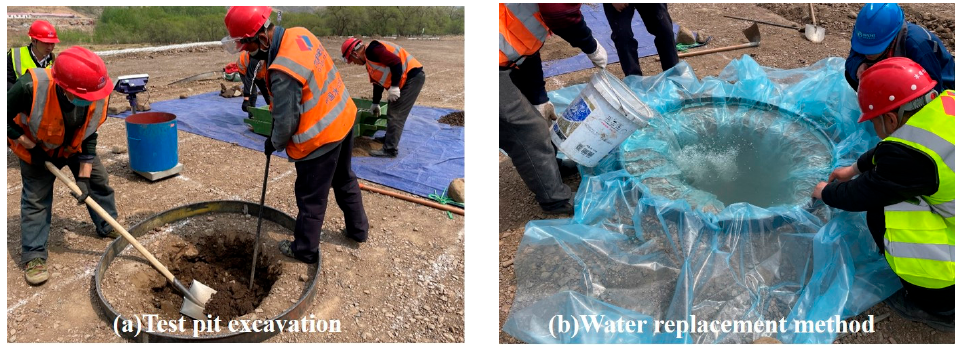
Figure 9. Density testing: ( a ) Test pit excavation and ( b ) Water replacement method.